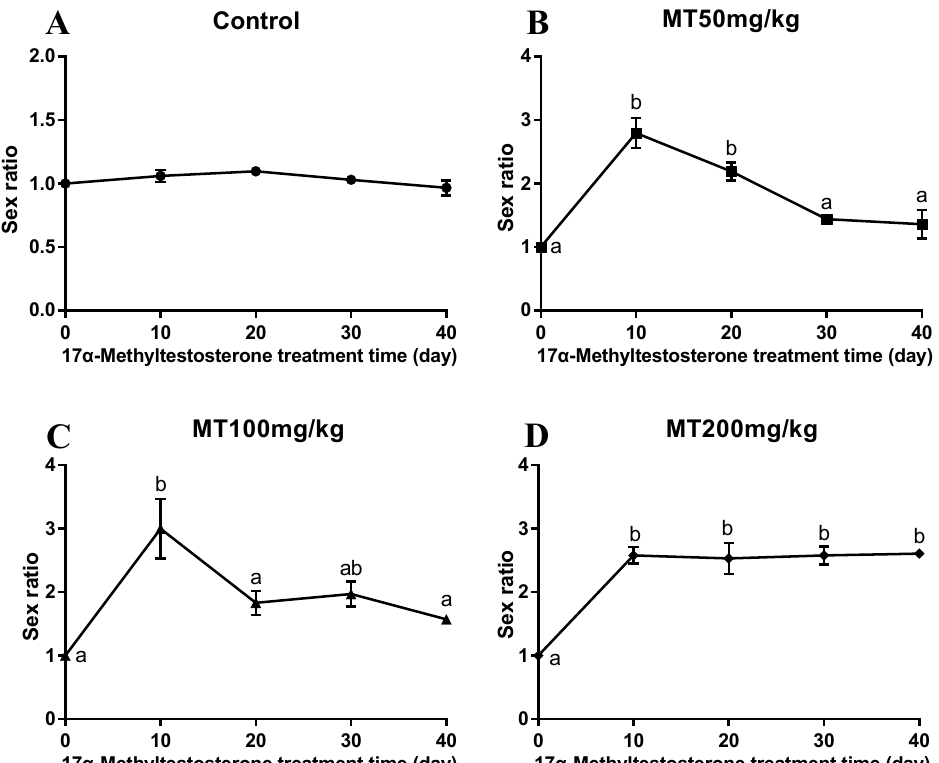
Figure 2. The sex ratio at four different concentrations of MT over time. ( A ) Control; ( B ) 50 mg/kg MT; ( C ) 100 mg/kg MT; ( D ) 200 mg/kg MT. Data are shown as mean ± SEM of tissues from separate individuals (n = 3). Lowercase letters indicate differences in expression between different samples in the same group.